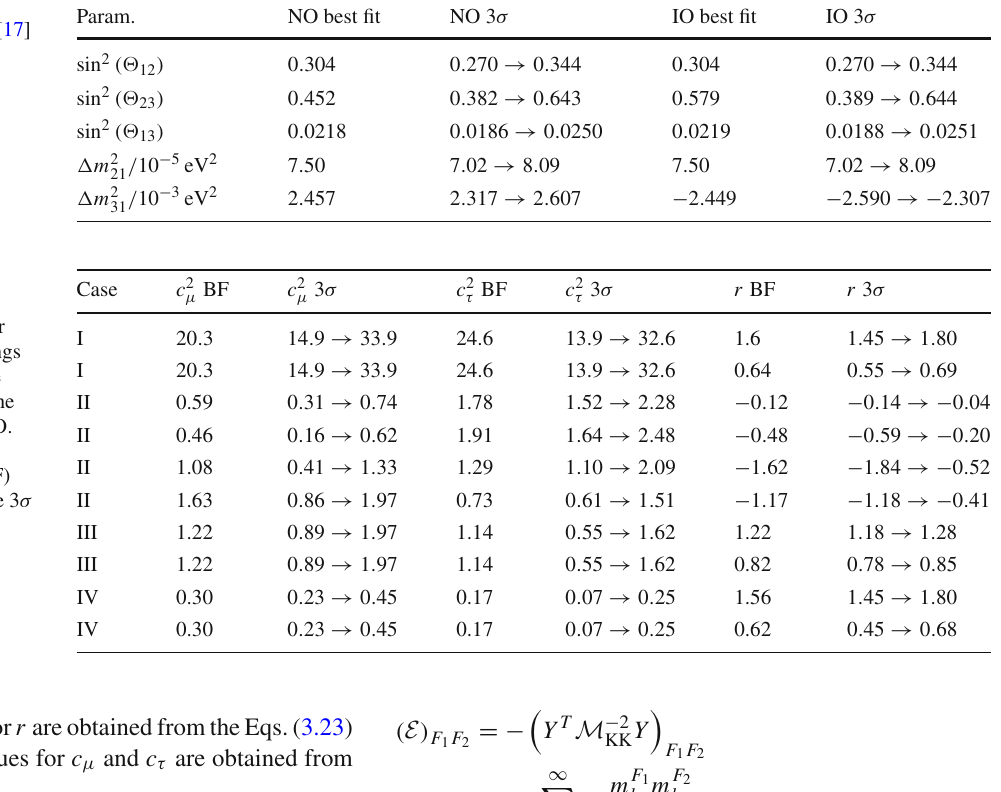
oscillation parameters from [17]